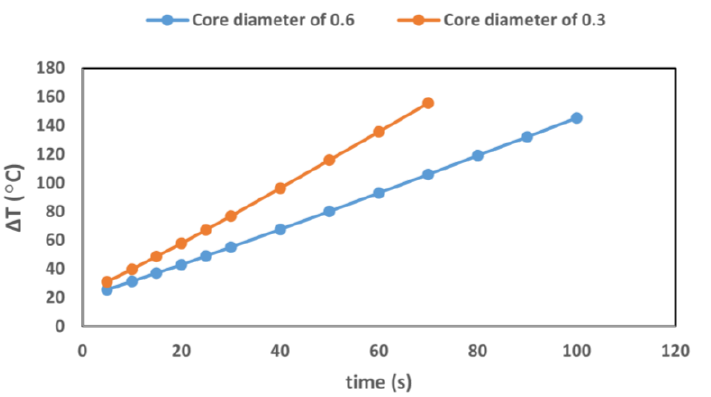
Figure 7. Temperature increases in the GNRs-loaded tumor when exposed to laser irradiation, at a power of 2.1 W with two laser applicator diameters: 0.3 mm (orange) and 0.6 mm (blue).